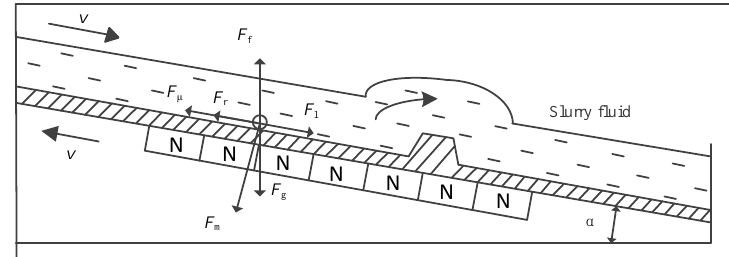
Figure 2. Force analysis of magnetic particle.